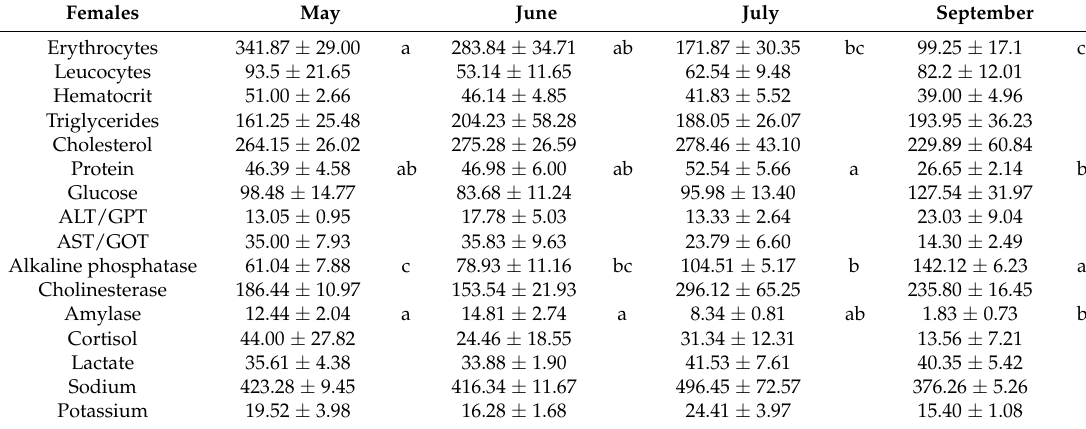
Table 4. Erythrocytes (10 4 mm − 3 ), leucocytes (10 3 mm − 3 ), hematocrit (%), triglycerides (mg dL − 1 ),